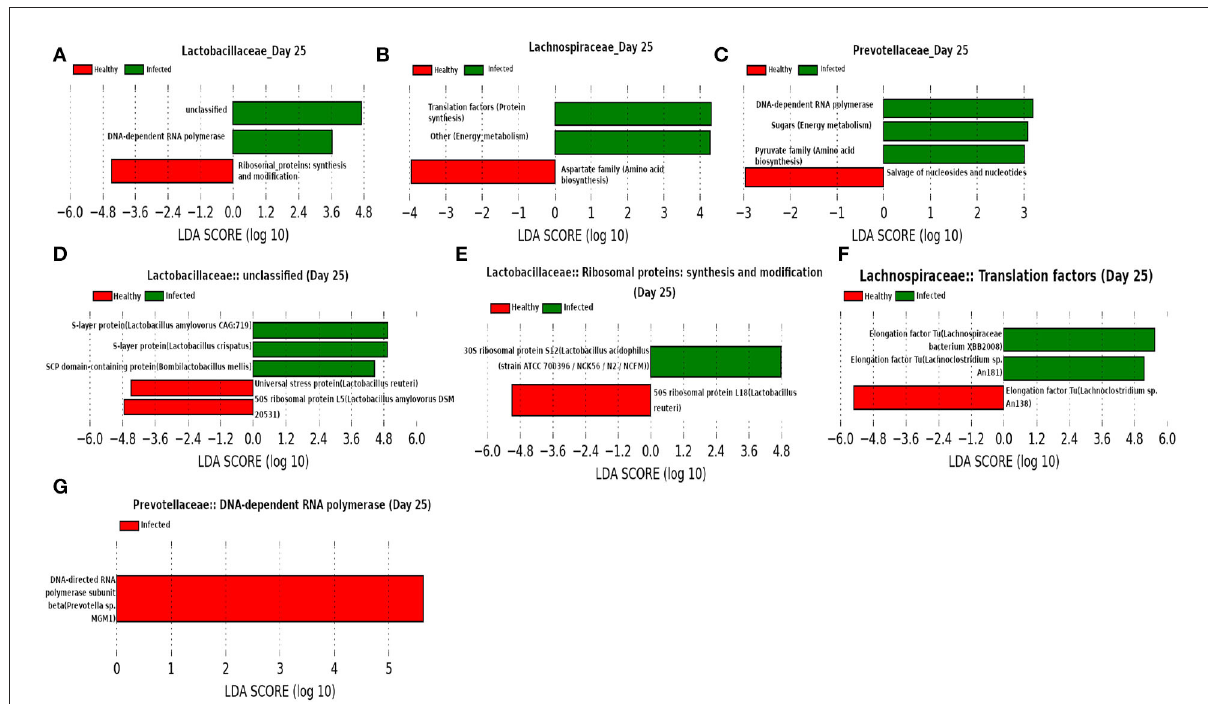
FIGURE15 (A–C) Linear discriminant analysis effect size (LEfSe) scores of the enriched functions of the dominant microbiome family, ASVs of which are found to be the member of infected-core-hub community or act as hubs or key-drivers in the infected cohort at day 25. (D–G) Linear discriminant analysis effect size (LEfSe) scores of the predicted biomarkers involved in the enriched microbial functions associated with healthy and infected cohorts at day